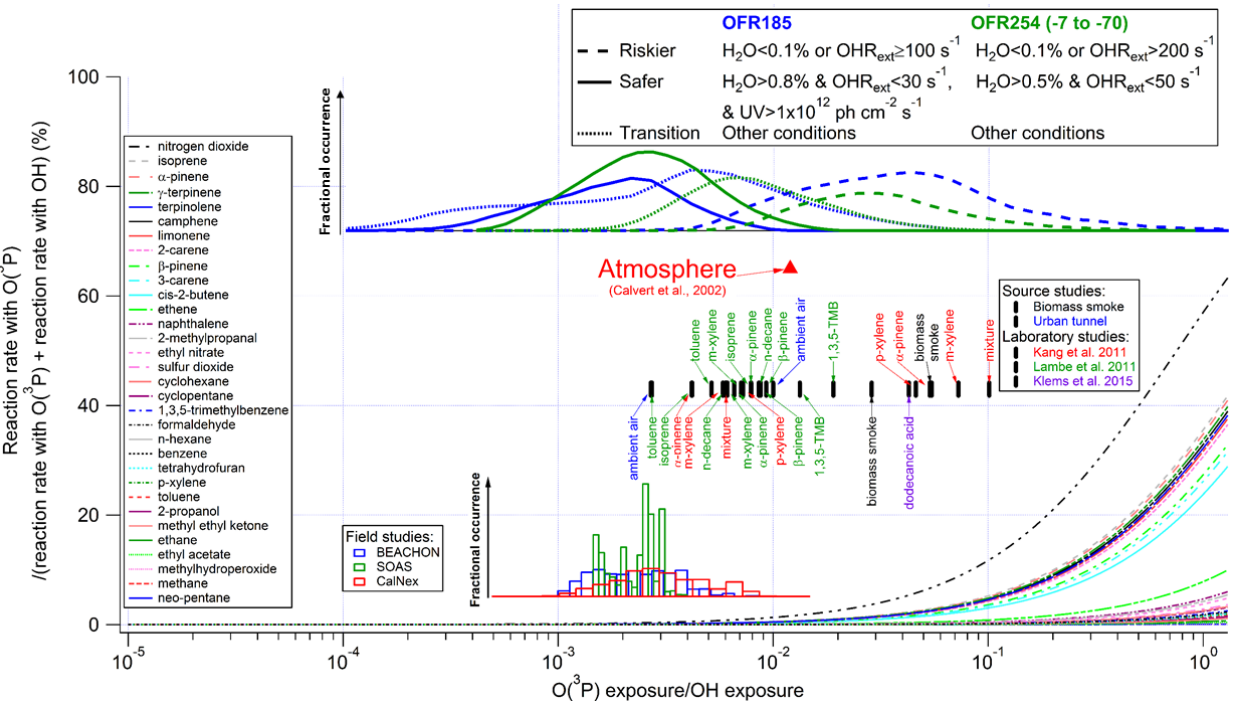
Figure 4. Same format as Fig. 3 but for the ratio of the reaction rate with O( 3 P) vs. OH as a function of the relative exposure of O( 3 P) and OH. A typical value of the relative exposure of O( 3 P) and OH in the troposphere from Calvert et al. (2002) is also shown.